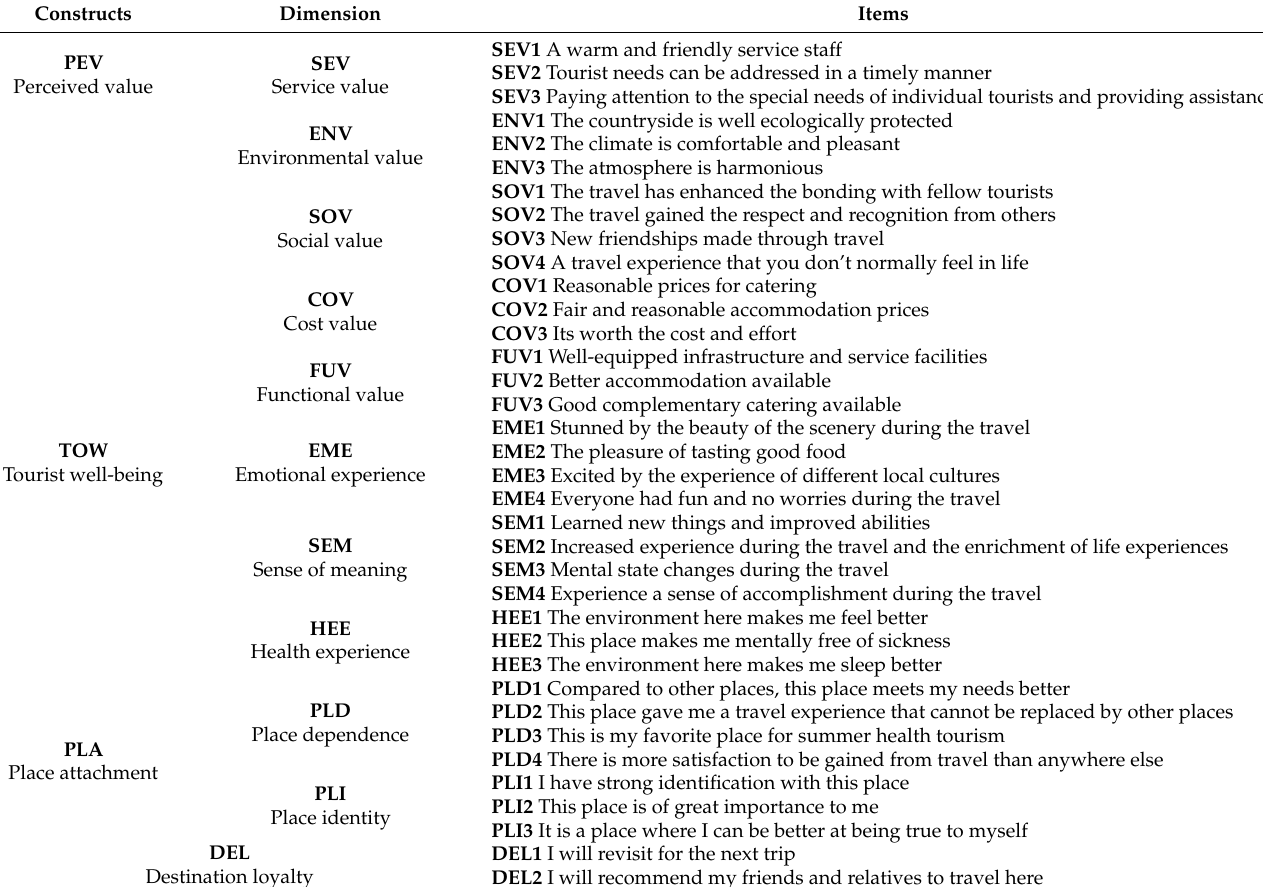
Table 1. Measurement items for each